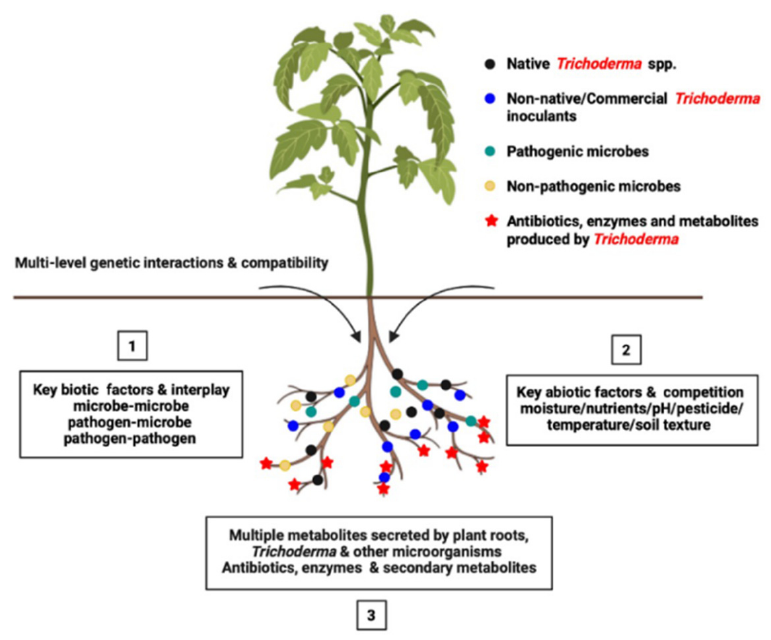
Figure 2. Soil ecological challenges and factors (1. Biotic, 2. Abiotic, and 3. Metabolomics) of Trichoderma bioinoculants’ survival, establishment, and function in crop rhizosphere.